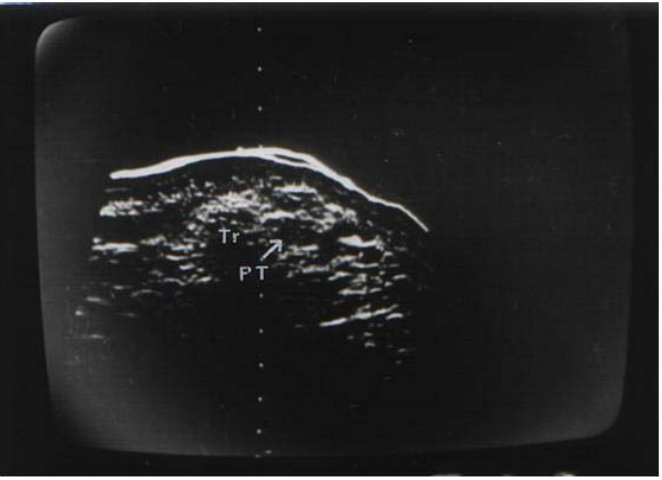
FIGURE 1. Echographic presentation of PTG with compound ultrasonography and 5-MHz